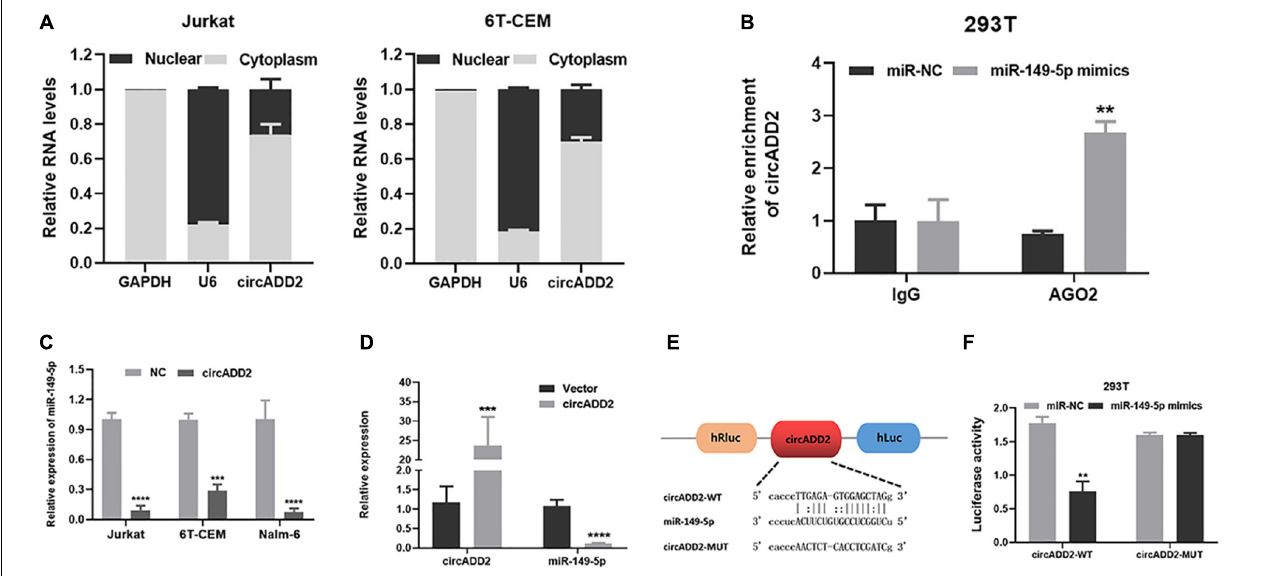
FIGURE 4 | CircADD2 sponged miR-149-5p. (A) Cellular localization of circADD2 in Jurkat and 6T-CEM. Results revealed that circADD2 was mainly expressed in the cytoplasm ALL cells. (B) CircADD2 levels in purified RNA collected from products of anti-AGO2 or anti-IgG was detected by RT-qPCR. After miR-149-5p mimics was transfected into 293T cells, significant enrichment of circADD2 in the RNA complex immunoprecipitated by AGO2 antibody was observed. (C) qRT-PCR confirmed the decreased level of miR-149-5p in ALL cells after overexpression of circADD2. (D) CircADD2 and miR-149-5p levels were detected by qRT-PCR in tumor cells from xenograft generated by Jurkat cells stably transfected with circADD2 or control vector. MiR-149-5p level was significantly decreased after circADD2 overexpression in vivo , while circADD2 level was elevated. (E,F) Dual luciferase reporter assay was used to prove the binding between circADD2 and miR-149-5p. The fluorescence activity of circADD2–WT was reduced and the fluorescence activity in circADD2–MUT was basically unchanged when transfected with miR–149-5p mimics. Data were showed as mean ± SD and analyzed by unpaired t -test, ** P < 0.01, *** P < 0.001, **** P <